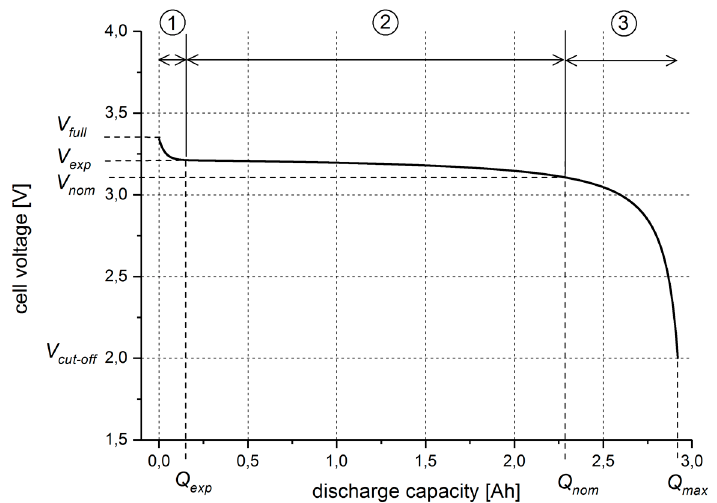
Figure 6. Simulated discharge curve of one lithium-ion cell, 1C rate (US26659) based on data sheet specifications [50].